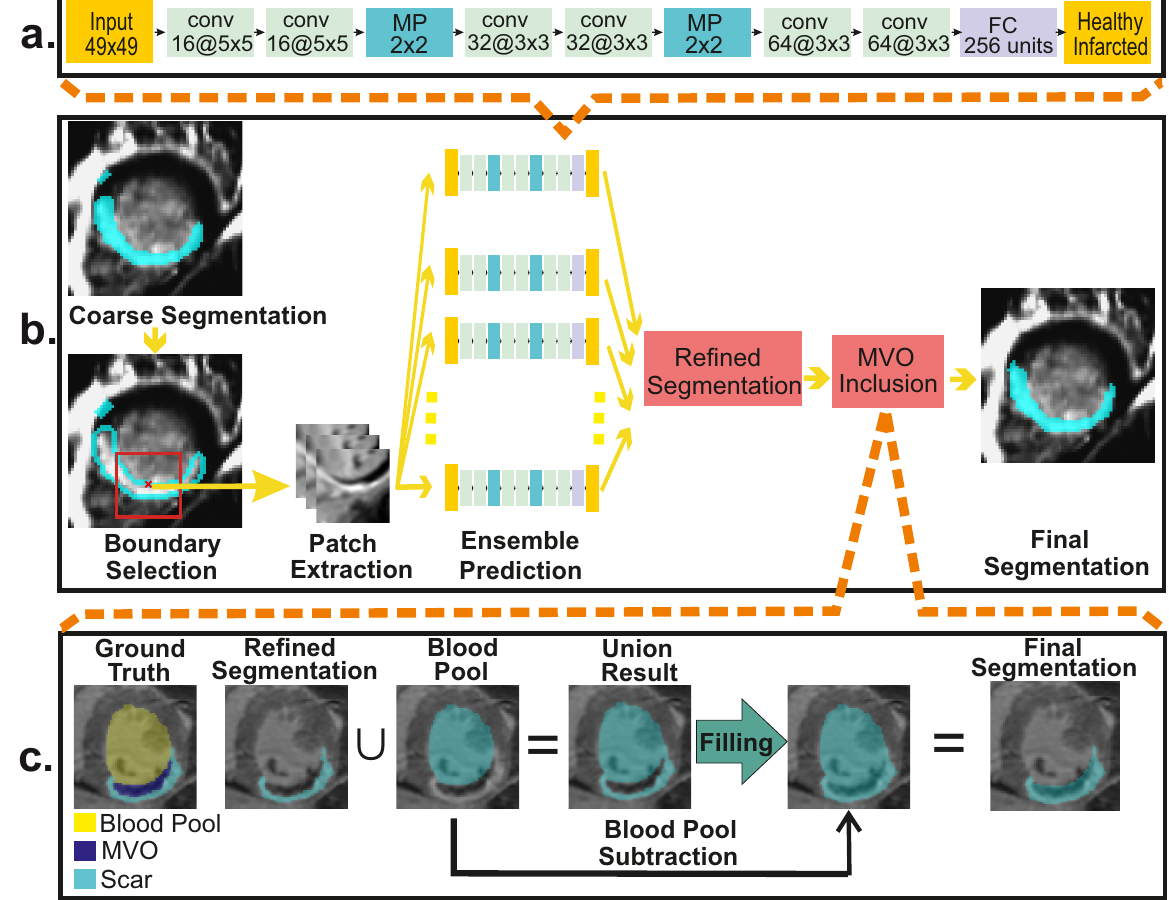
Figure 2. Segmentation refinement block. ( a ) CNN architecture used in the ensemble. ( b ) Refinement segmentation workflow. ( c ) Microvascular obstruction inclusion workflow. conv: Convolutional Layer; MP: Max-Pooling Layer; FC: Fully Connected Layer. × indicates the central voxel of the patch to be